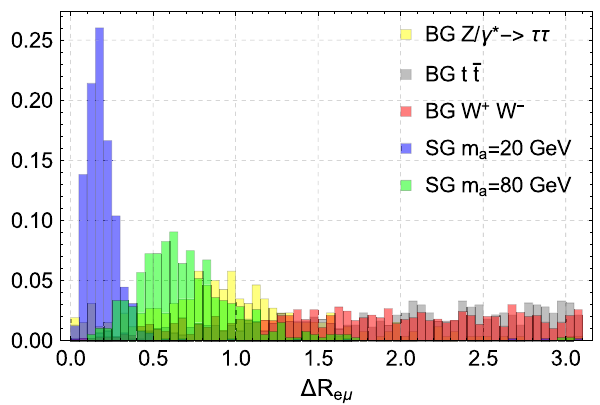
Fig. 4 Angular separation ( Δ R e μ ) between the two leptons for two signal (SG) masses (20 and 80 GeV) compared to the most relevant backgrounds (BG). Small separation angles can be a good discriminant particularly for low